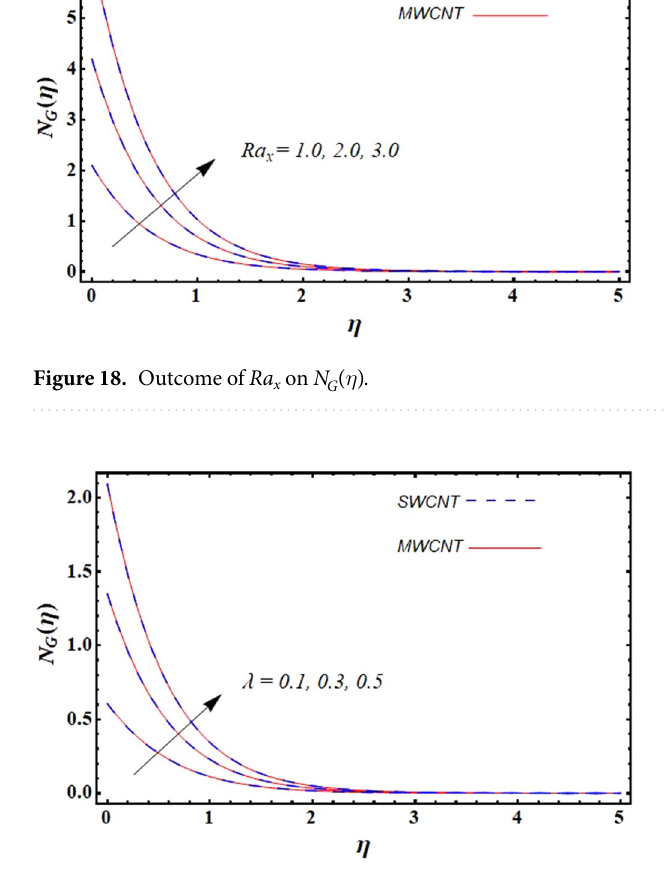
Figure 19. Outcome of λ on η N ( )